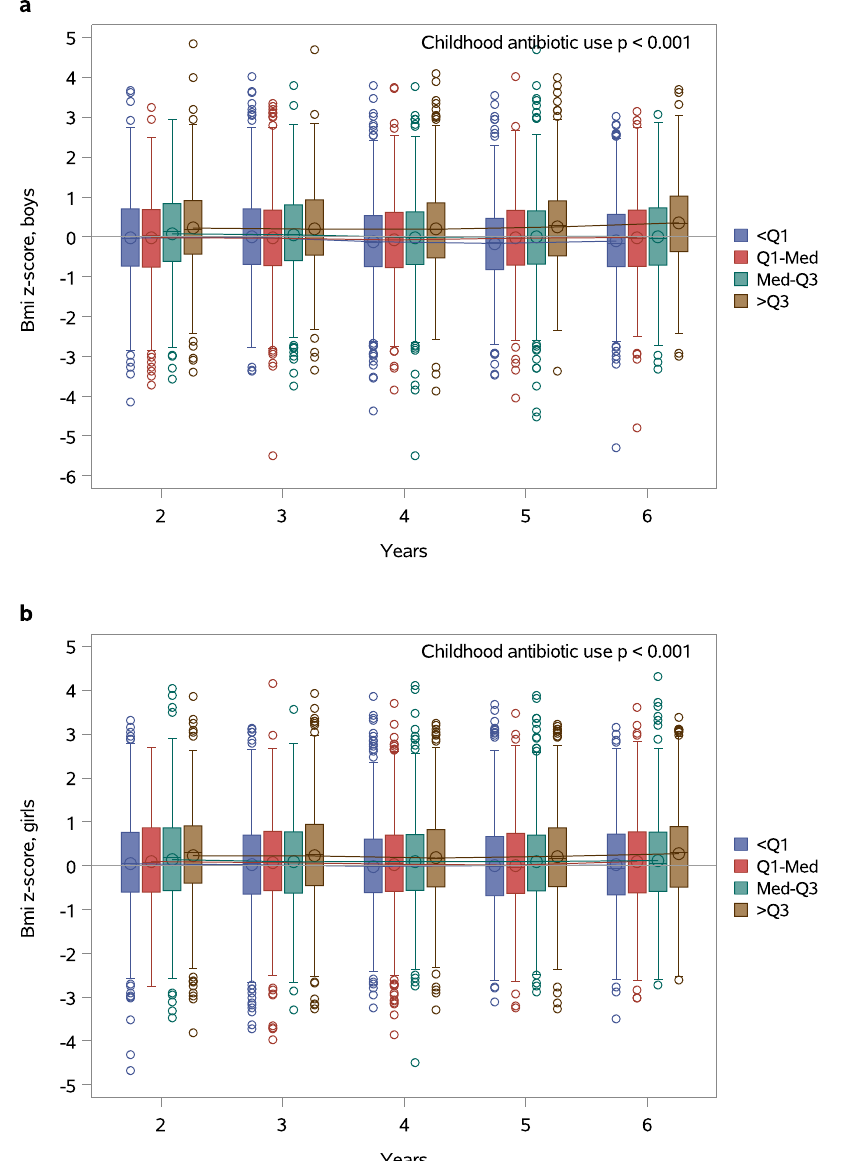
Fig. 2 Early childhood antibiotic exposure is associated with increased BMI. The association between childhood antibiotic use and BMI Z-scores during the fi rst six years of life in boys ( a ) and girls ( b ). The subjects have been categorized by quartiles (Q1, median, and Q3) based on the cumulative number of antibiotic purchases at each point in time. The number of antibiotic purchases was associated with signi fi cantly higher BMI Z-scores during the fi rst six years of life in both boys ( p < 0.001) and girls ( p < 0.001) in a hierarchical linear mixed model for repeated measurements adjusted for gestational age, birth weight Z-score, mode of delivery, maternal prepregnancy BMI and neonatal antibiotic exposure. The boxes represent interquartile range (IQR) and the whiskers represent 1.5 times IQR. The circles represent